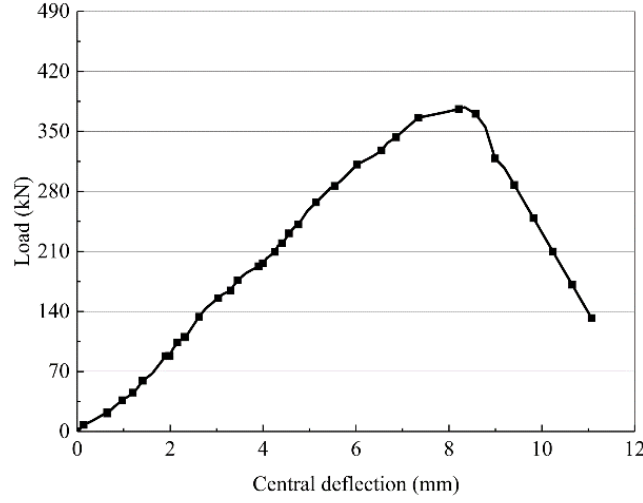
Figure 6. Central deflection and load curves of RC-con beam.